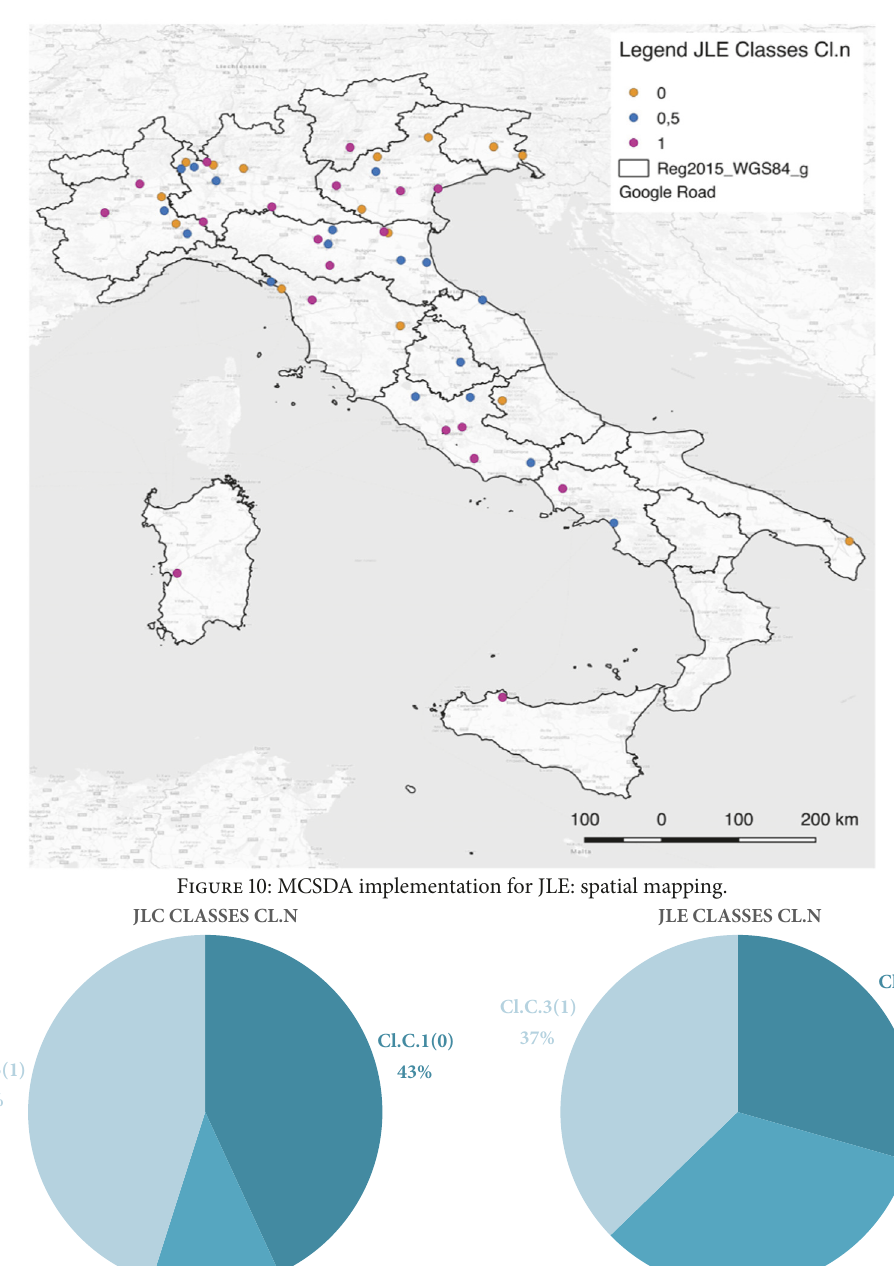
Figure 11: Analysis of output of evaluation for alternatives A.n for JLC, “overall classification of resources”, and JLE, “airport potential